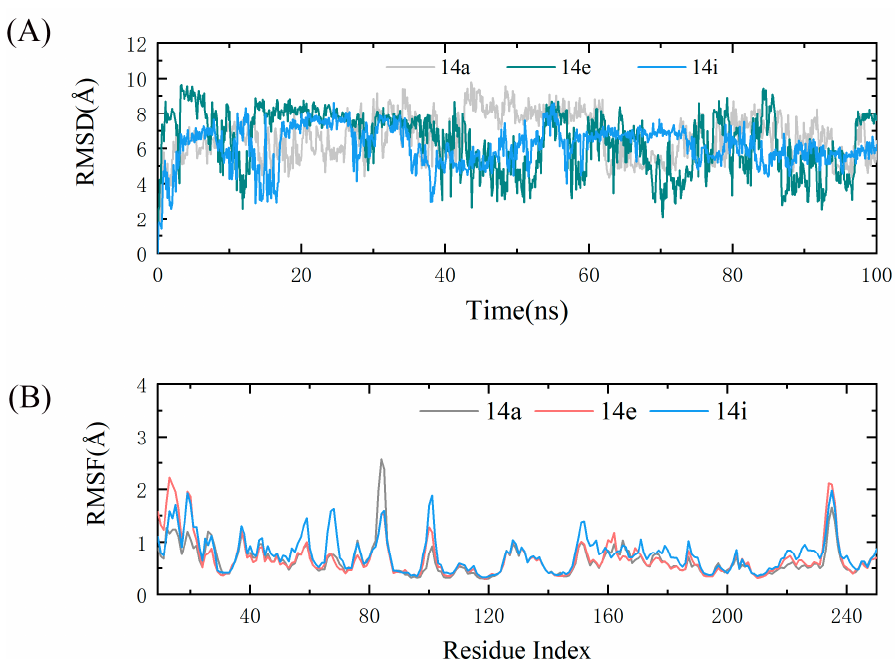
Figure 3. The Root ‐ mean ‐ square deviation (RMSD) and Root ‐ mean ‐ square fluctuations (RMSF) of Figure 3. The Root-mean-square deviation (RMSD) and Root-mean-square fluctuations (RMSF) of CA IX protein during the whole MD simulations. ( A ) RMSD plots of CA IX ‐ compound 14a CA IX protein during the whole MD simulations. ( A ) RMSD plots of CA IX-compound 14a complex complex (grey), CA IX ‐ compound 14e complex (green) and CA IX ‐ compound 14i complex (blue). (grey), CA IX-compound 14e complex (green) and CA IX-compound 14i complex (blue). ( B ) RMSF ( B ) RMSF plots of CA IX ‐ compound 14a (grey), CA IX ‐ compound 14e complex (orange) and CA plots of CA IX-compound 14a (grey), CA IX-compound 14e complex (orange) and CA IX-compound IX ‐ compound 14i complex (blue). 14i complex